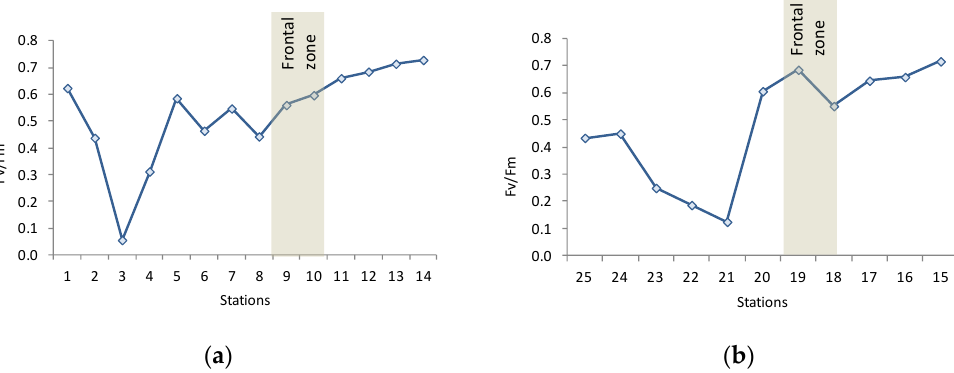
Figure 6. Distribution of surface F v /F m in the study area at stage 1 ( a ) and stage 2 ( b ).